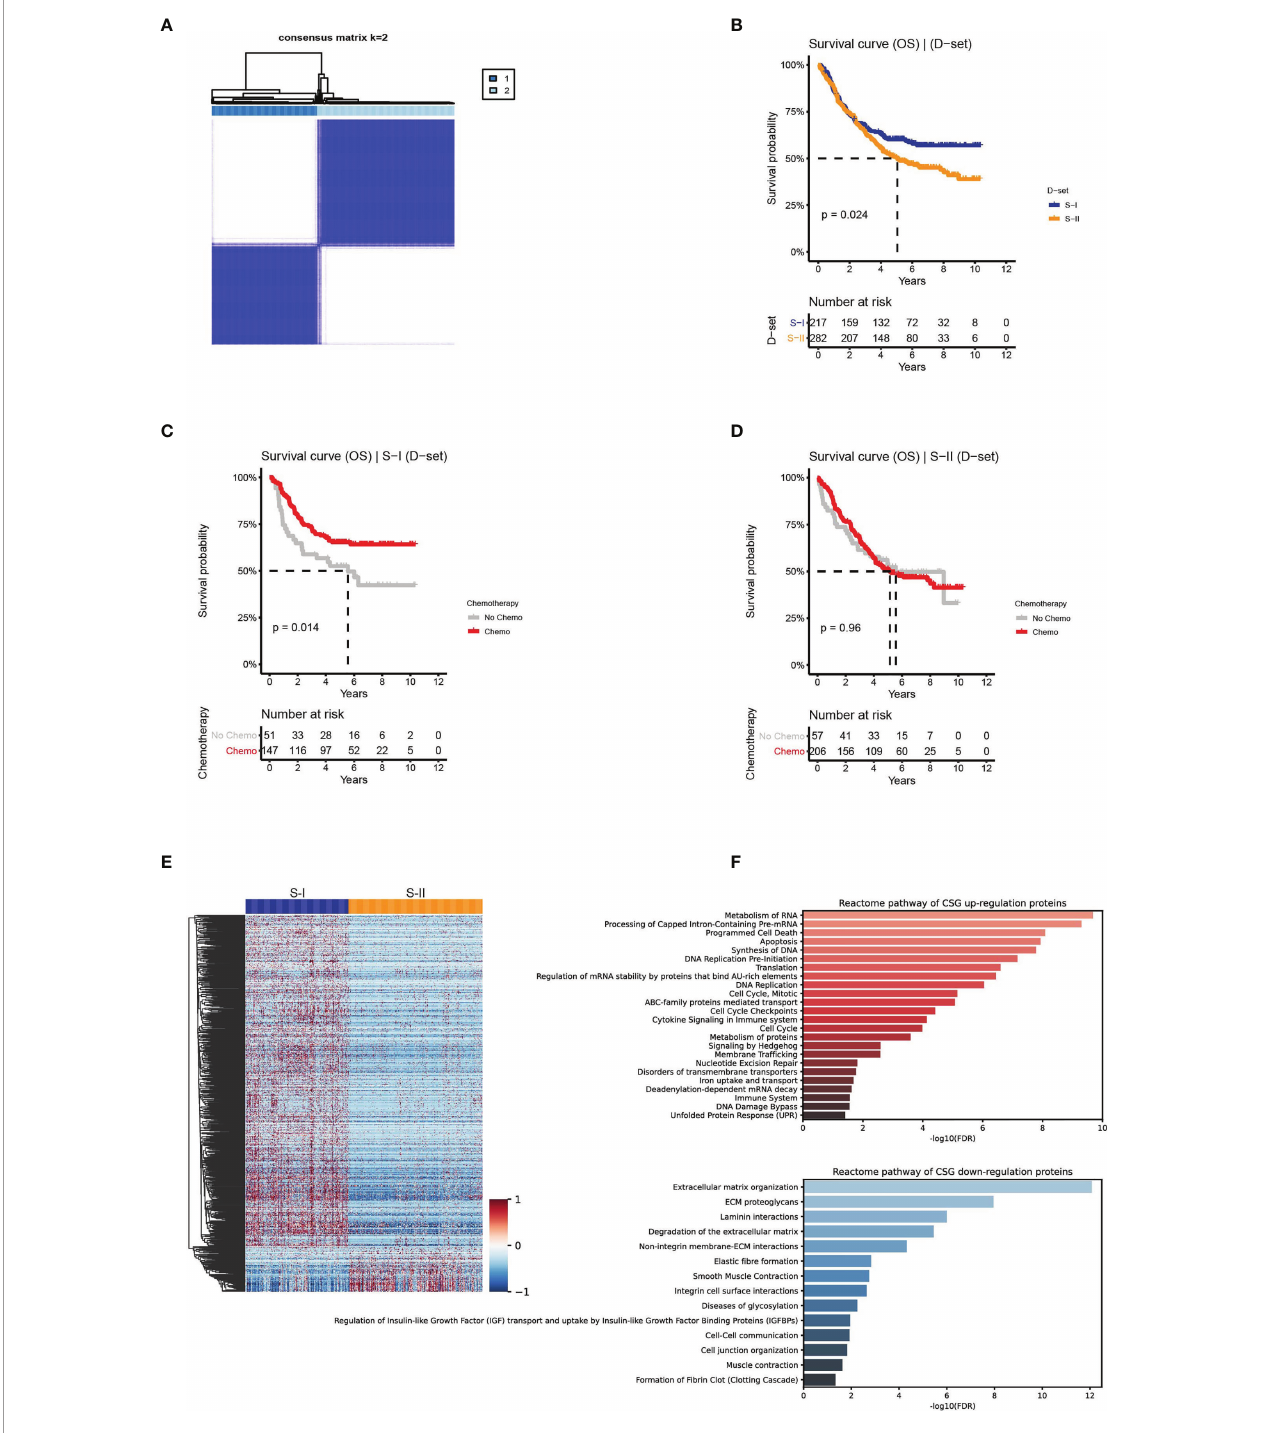
FIGURE 2 | Clinical outcomes and differentially expressed proteins with their enriched pathways of the molecular subtypes in the discovery set. (A) The discovery set was clustered using the ConsensusClusterPlus method based on the protein features transformed from AE. (B) The OS of S-I and S-II. (C, D) The OS by chemotherapy status for S-I and S-II. (E) Differentially expressed proteins in the two subtypes. (F) Reactome revealed the pathways that were signi fi cantly enriched in the proteomic